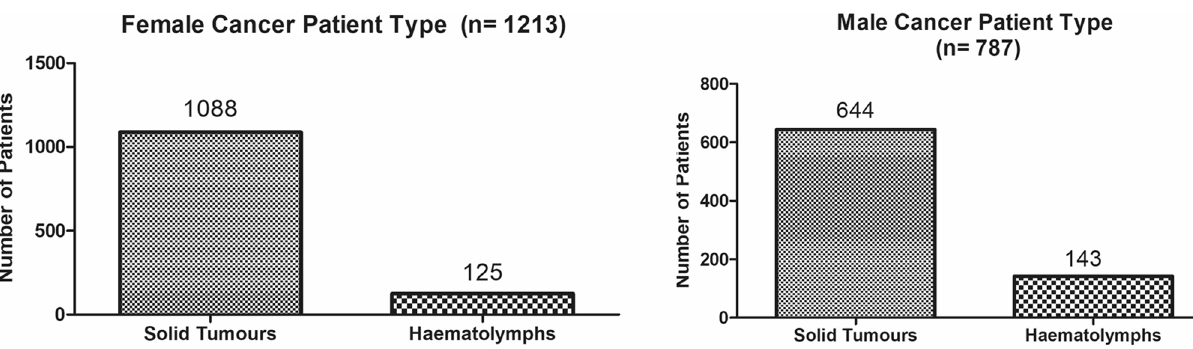
Figure 4. Graph showing type of cancer in female and male patients (ANOVA-Dunnett’s Test, P < 0.05).